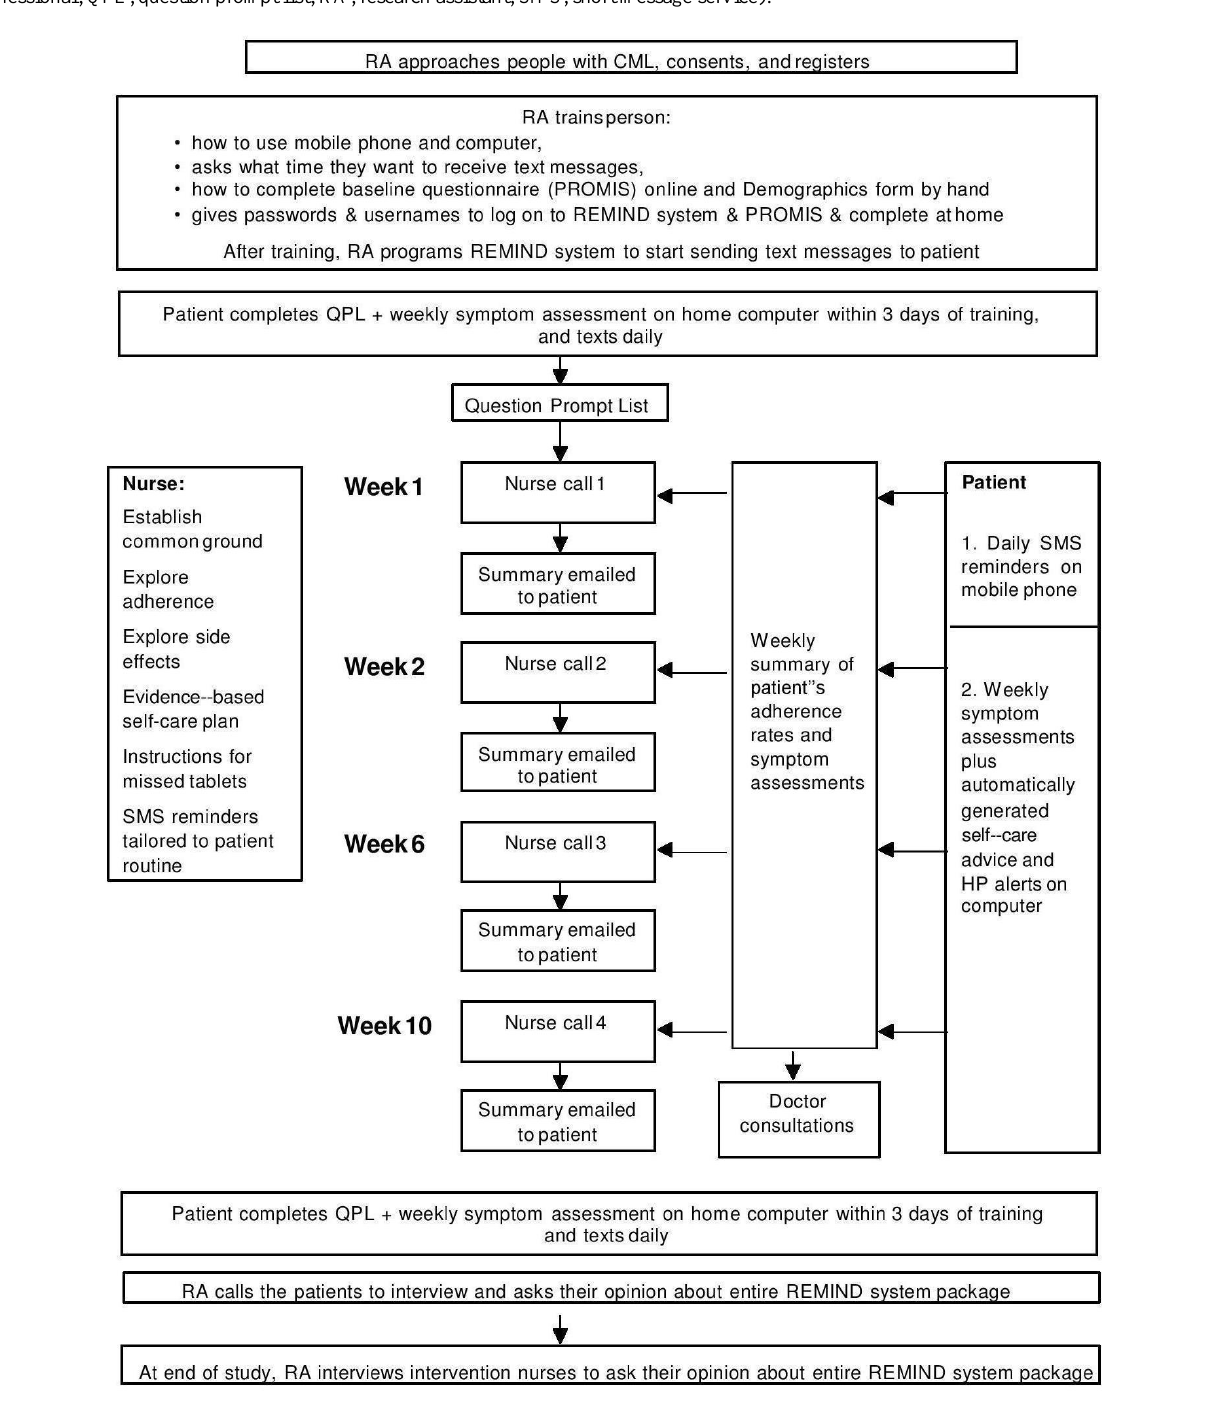
Figure 1. Flowchart of the nurse-mediated telehealth (including REMIND system) intervention package (CML, chronic myeloid leukaemia; HP, health professional; QPL, question prompt list; RA, research assistant; SMS, short message